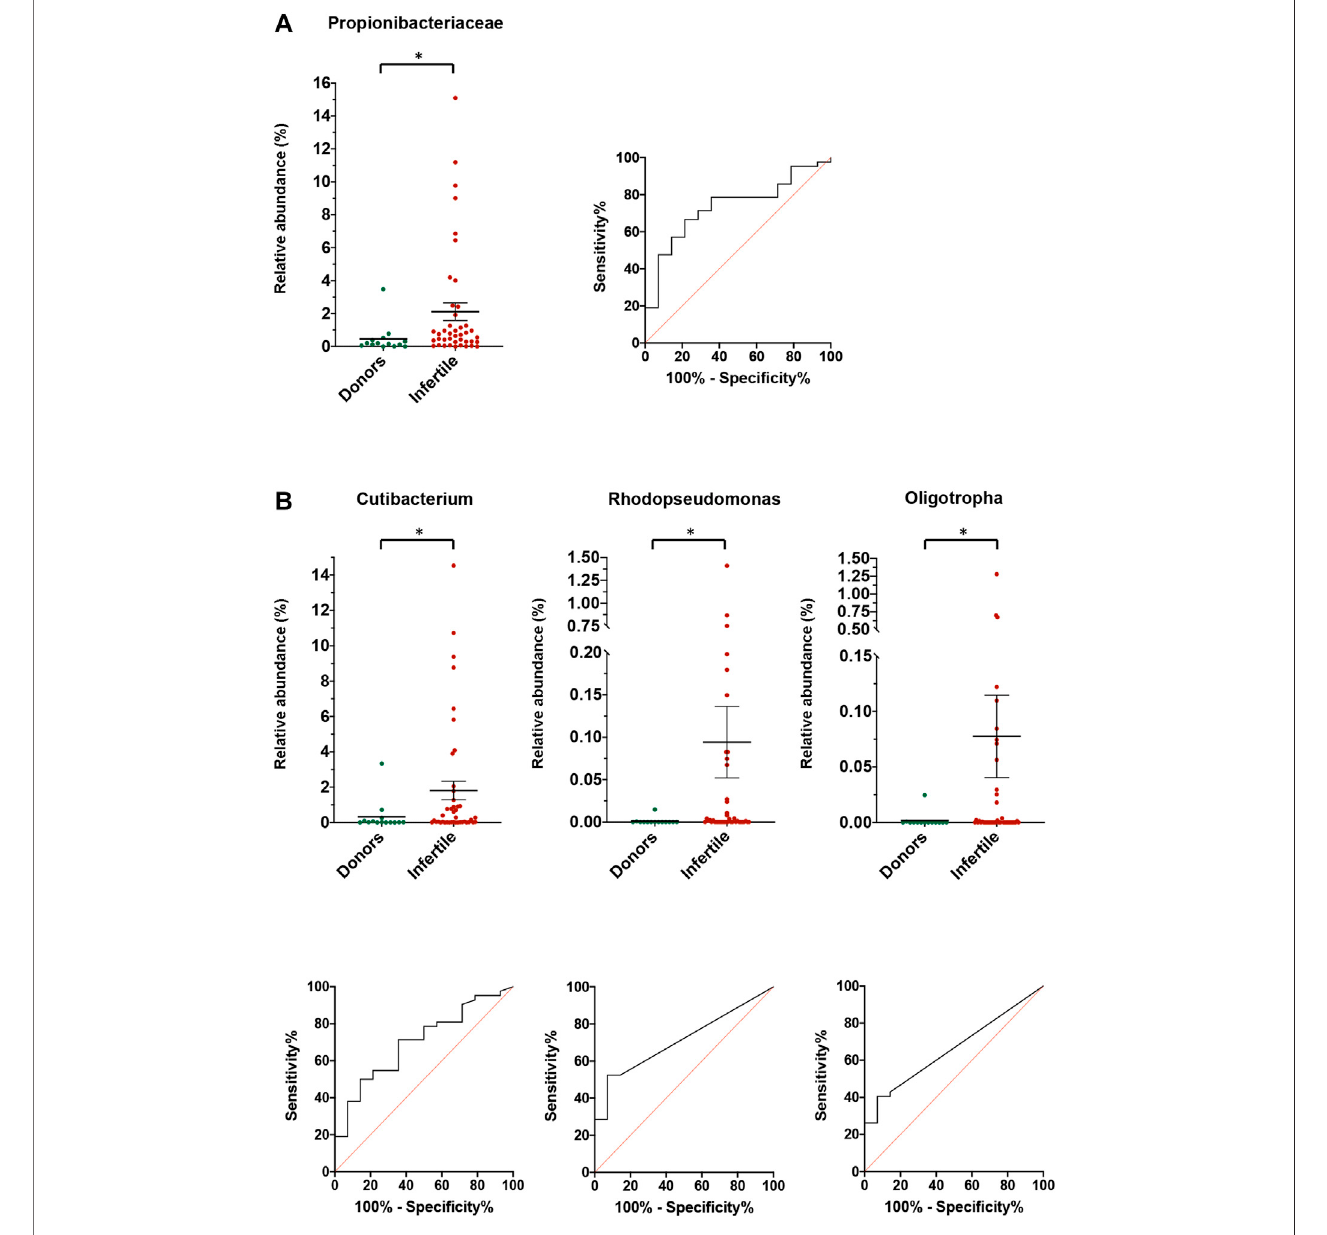
FIGURE 4 | Relative abundance for donors and fertile individuals and infertile patients for (A) families, and (B) genera. For each family or genera, the relative abundanceand theROCcurve forthepredictionofinfertility isshown.Linesand barsshowaverage±SEM.*Statistically signi fi cantdifferences betweenthetwogroups.